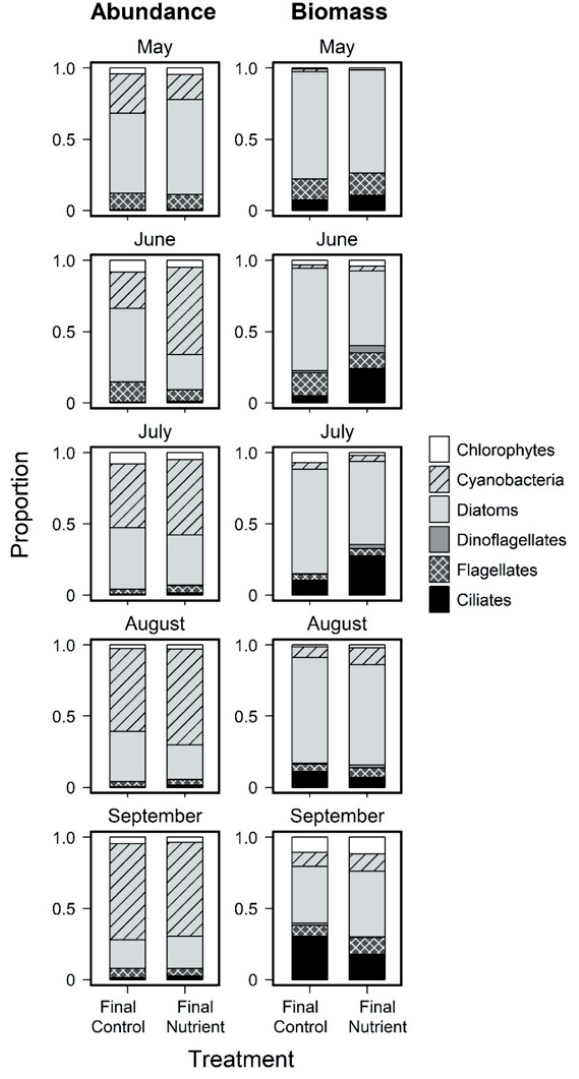
Figure 5. Proportional abundance ( left ) and proportional carbon biomass ( right ) of microplankton taxa for Day 5 final control and Day 5 final nutrient ‐ amended samples. Rhodophytes were not present in any Day 5 final control or final nutrient ‐ amended sample and are therefore not shown.